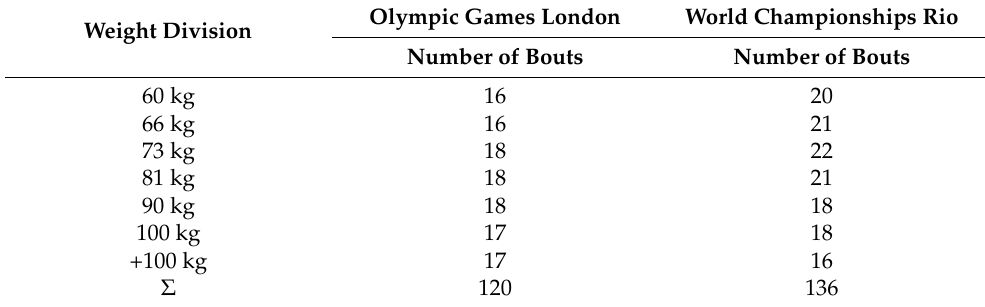
Table 2. Number and duration of bouts fought during the Olympic Games in London in 2012 and the World Championships in Rio de Janeiro in 2013, including weight divisions. Olympic Games London World Championships Rio Weight Division Number of